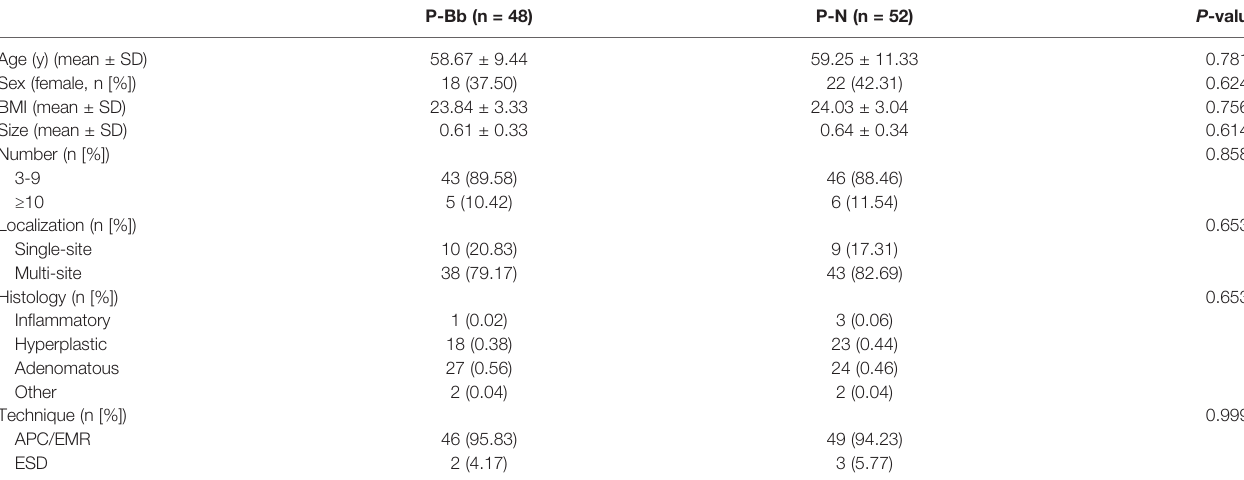
TABLE 1 | Baseline